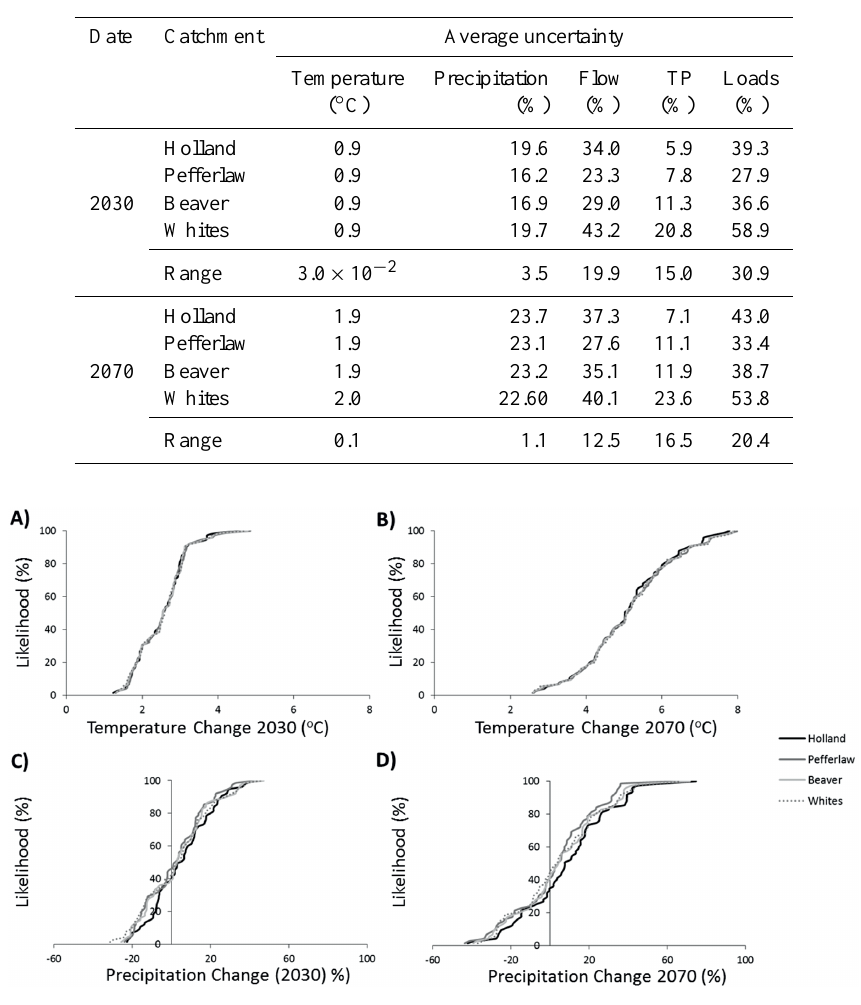
Figure 9. Between-catchment comparison of the CDFs from the perturbed physics ensemble of (a) monthly change in temperature by 2030, (b) monthly change in temperature by 2070, (c) monthly change in precipitation by 2030, (d) monthly change in precipitation by 2070 (CDF: cumulative distribution